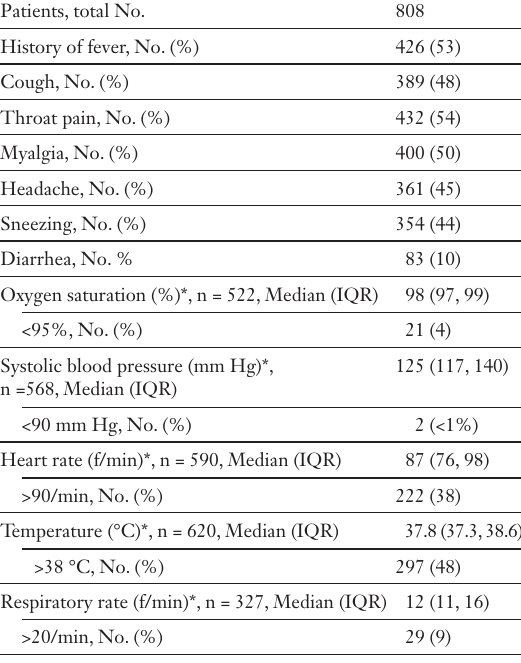
Symptoms and vital signs of ED patients with flu-like